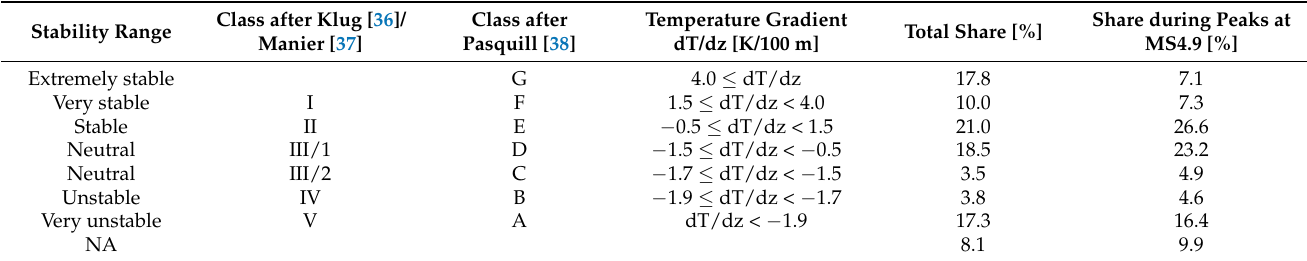
Table 1. Stability